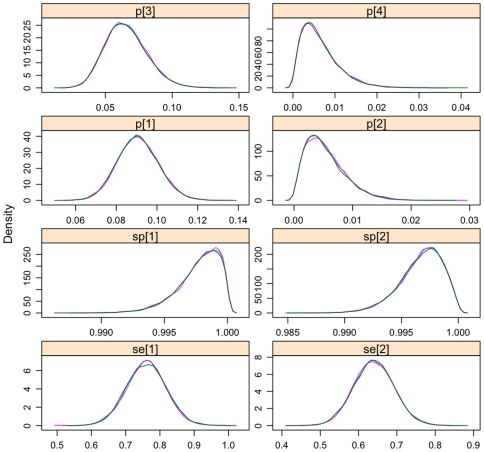
Probability density plots.Probability density plots for each test parameter estimate for the T. brucei s.l. specific PCR (sensitivity = Se[1]; specificity = Sp[1]), T. brucei s.l. ITS-PCR (sensitivity = Se[2]; specificity = Sp[2]) and the adjusted prevalence estimates from the Hui-Walter model assuming conditional independence for cattle (p[1]), goats (p[2]), pigs (p[3]) and sheep (p[4]). The x axes give the parameter estimate and the y axis the relative likelihood of it taking that value.